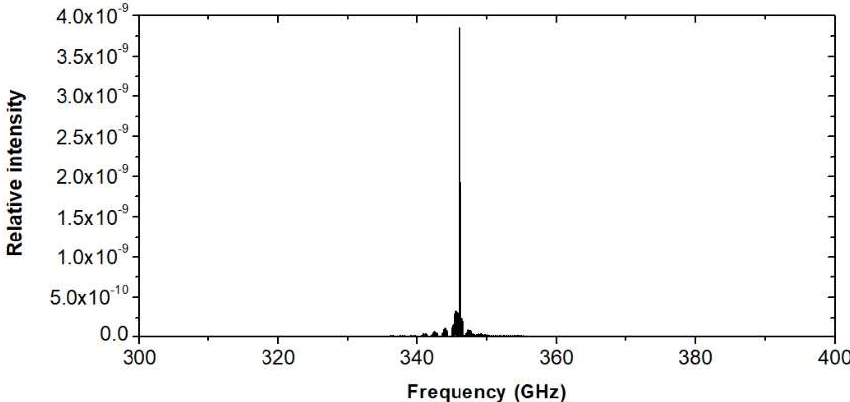
Figure 23. The Fourier transform of output signal.